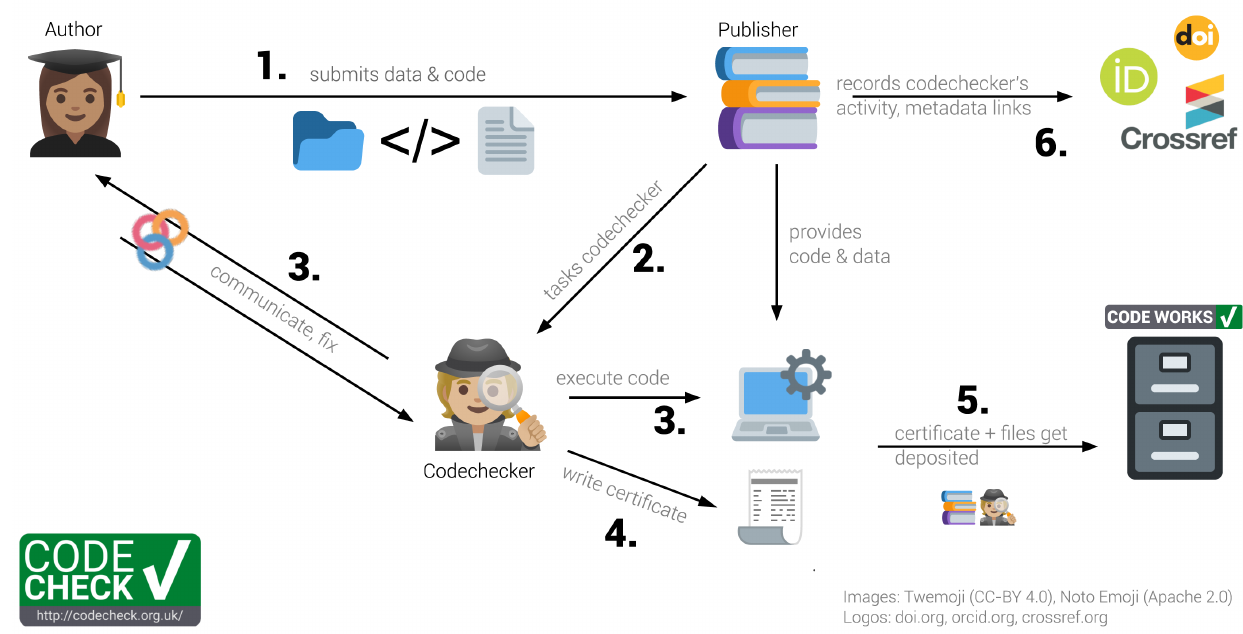
Figure 2. The CODECHECK example workflow implementation. Codecheckers act as detectives: They investigate and record, but do not fix issues. Numbers in bold refer to steps outlined in the